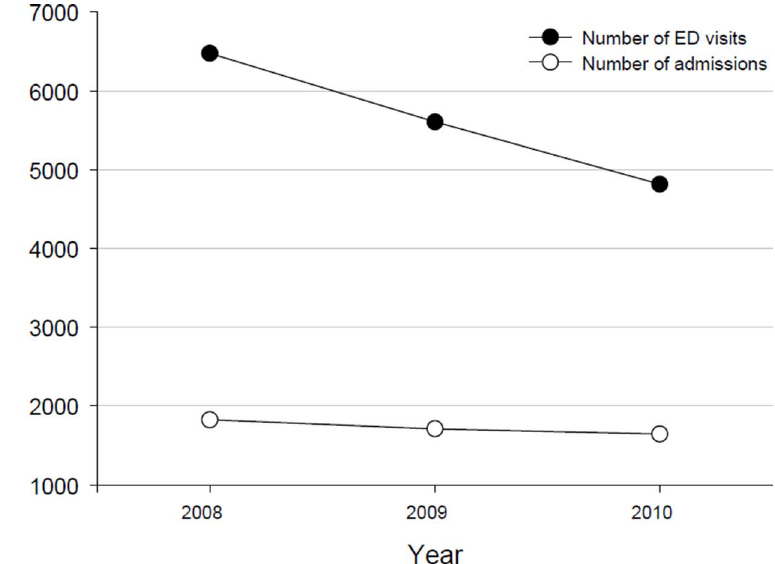
Figure 1. The number of ED visits and the number of hospitalizations due to physical abuse decreased over the analyzed time period (2008 to 2010).